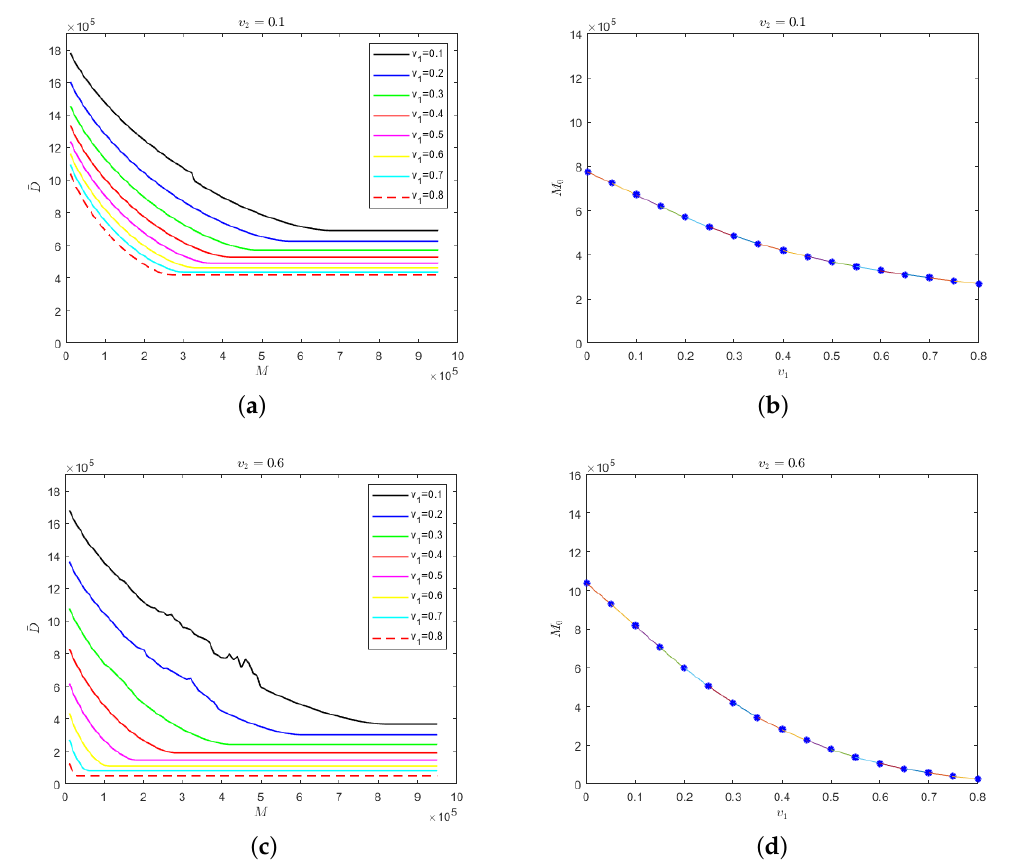
Figure 6. ( a ) Evolution results of the number of deaths in regard to the medical resources for different isolation rates of hospitalized mildly infected individuals when the isolation rate of hospitalized severely infected individuals is 0.1; ( b ) the relationship between safe medical resources and the isolation rate of hospitalized mildly infected individuals when the isolation rate of hospitalized severely infected individuals is 0.1; ( c ) evolution results of the number of deaths in regard to the medical resources for different isolation rates of hospitalized mildly infected individuals when the isolation rate of hospitalized severely infected individuals is 0.6; ( d ) the relationship between safe medical resources and the isolation rate of hospitalized mildly infected individuals when the isolation rate of hospitalized severely infected individuals is